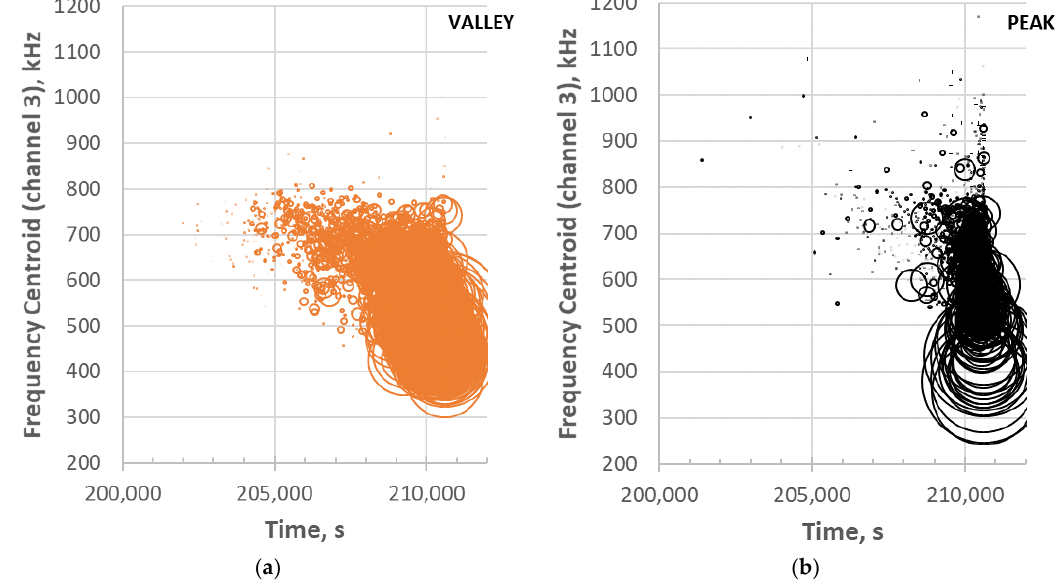
Figure 9. Frequency centroids for ( a ) valley and ( b ) peak events at the end of the test. Note that the bubble width is normalized to AE energy of the waveform.